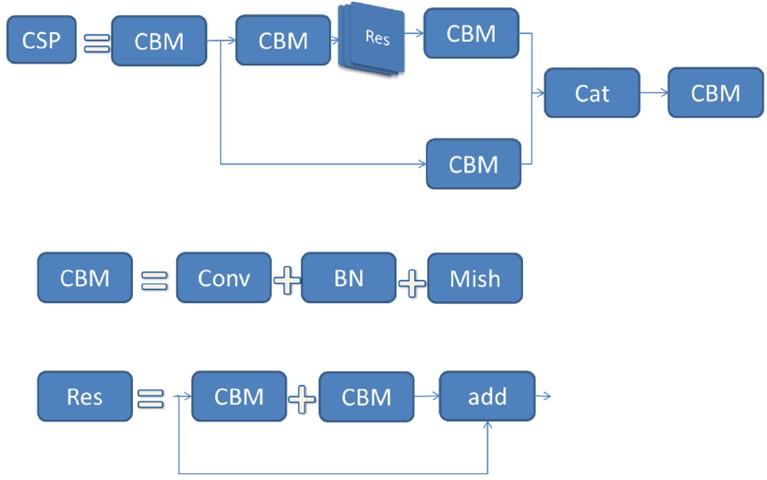
Figure 3. Structure diagram of CSP.